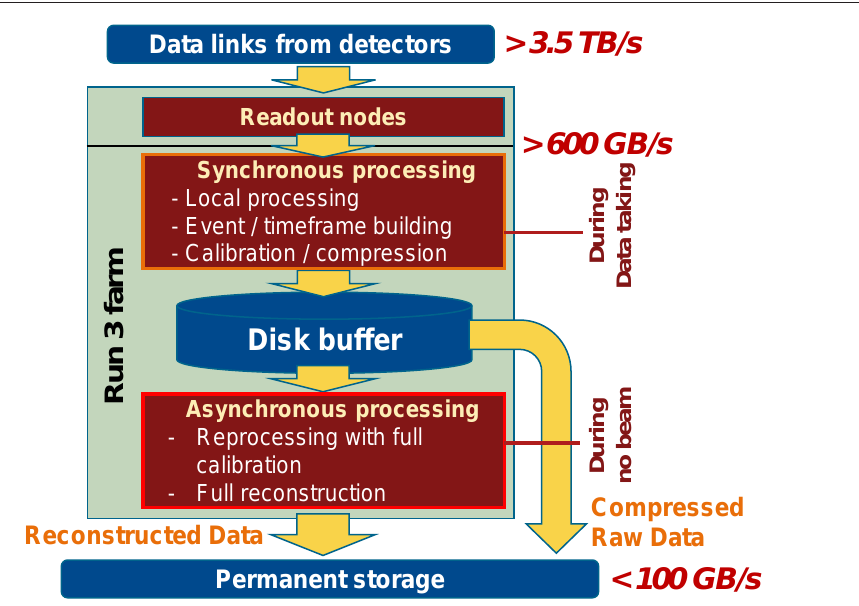
Figure 1. Illustration of the ALICE computing strategy for Run 3, with synchronous processing during data taking, and asynchronous processing in periods without